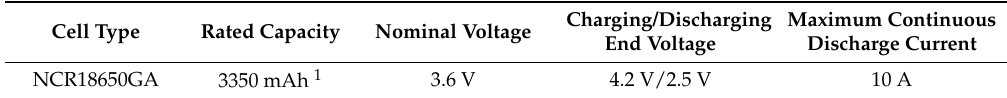
Table 3. The key specifications of the test cells.